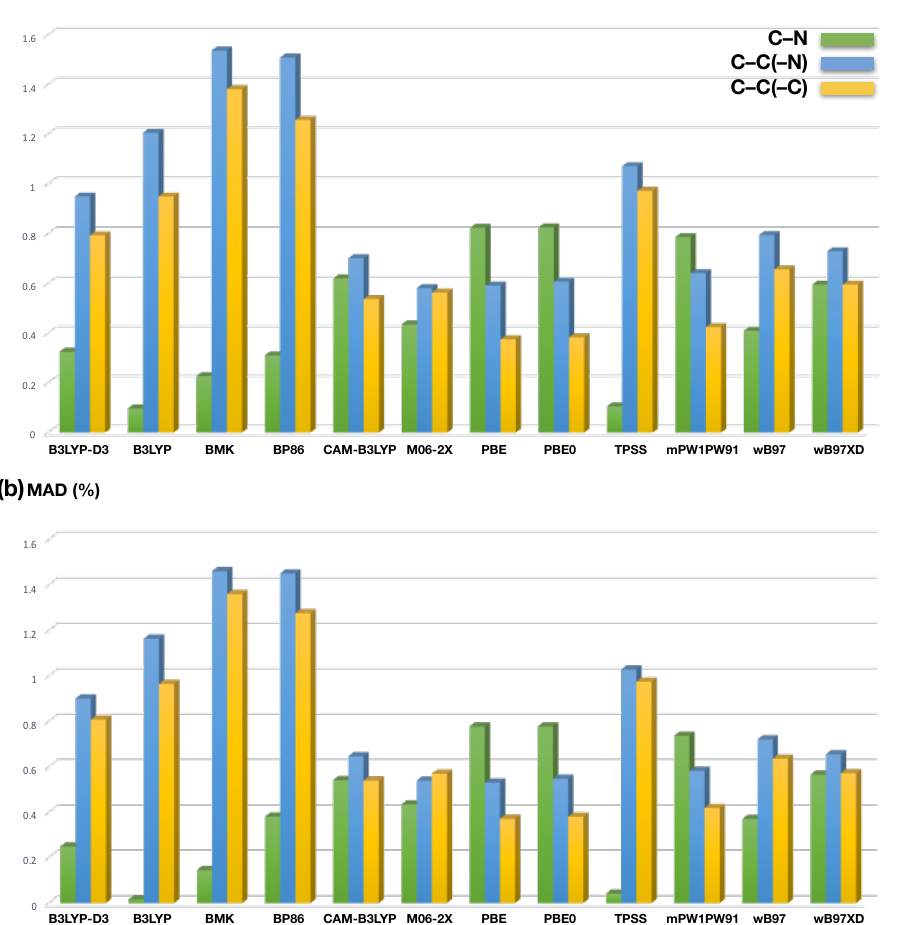
Figure 1. Benchmark result for isotripiperideine geometry optimization, where green bar represents C–N bond distance, blue bar represents C–C bond distance adjacent to nitrogen atom and yellow bar represents C–C bond distance adjacent to carbon atom: ( a ) benchmark calculation with 6-31G(d) Basis set; and ( b ) benchmark calculation with 6-31G+(d,p) Basis